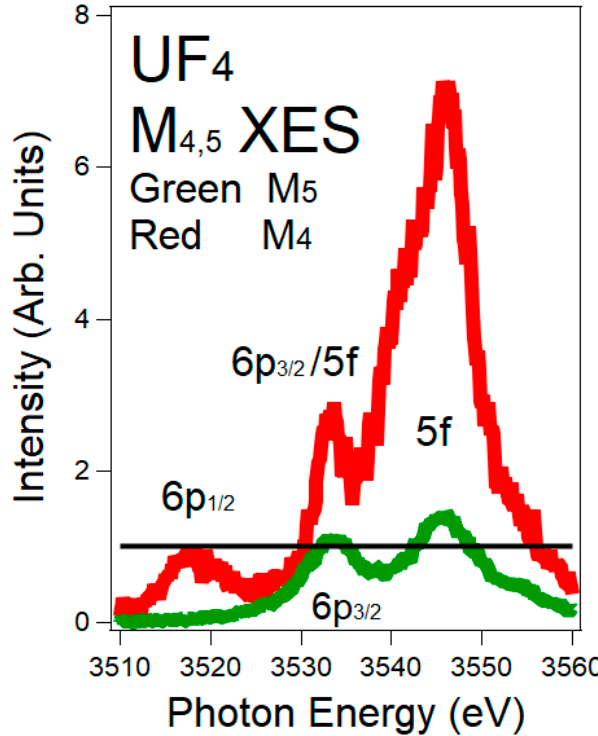
Figure 4. M 4 and M 5 X-ray Emission Spectroscopy (XES) spectra of UF 4 are shown here. The M 4 (M 5 ) spectrum corresponds to the 3d 3 / 2 (3d 5 / 2 ) hole. The normalization of the spectra is via the 6p peaks: M 4 6p 1 / 2 (p 1 / 2 → d 3 / 2 ) and M 5 6p 3 / 2 (p 3 / 2 → d 5 / 2 ), both ∆ j = 1. Red = M 4 . Green = M 5 . The black horizontal line is at unity (1). The intensity ratio of the 6p 1 / 2 :6p 3 / 2 is 0.8, following the electric dipole cross sections. In order to align the peaks on the M 5 energy scale, the M 4 spectrum has been shifted to − 181 eV. There is a very large enhancement of the 5f peak in the M 4 spectrum, versus that in the M 5 spectrum. This figure is similar to that of Figure 1 in [30]. The details of the normalization are available in [30].